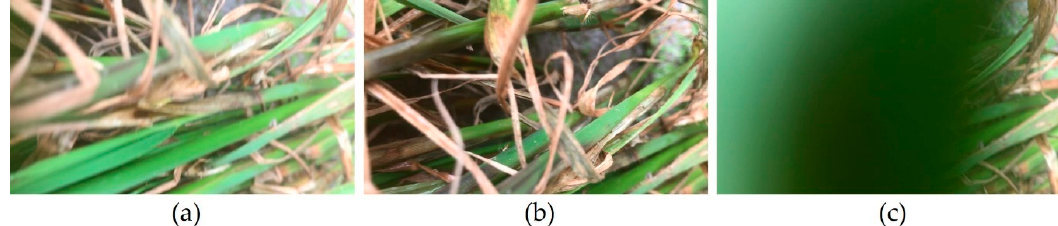
Figure 2. The challenges of rice video detection. Subgraphs ( a , b , c ) are frames of our video dataset (Video 1 illuminated in Section 2.1). ( a ) Video defocus, ( b ) motion blur, ( c ) part occlusion. Video 1 was captured in Hunan Province, China, July 2018.